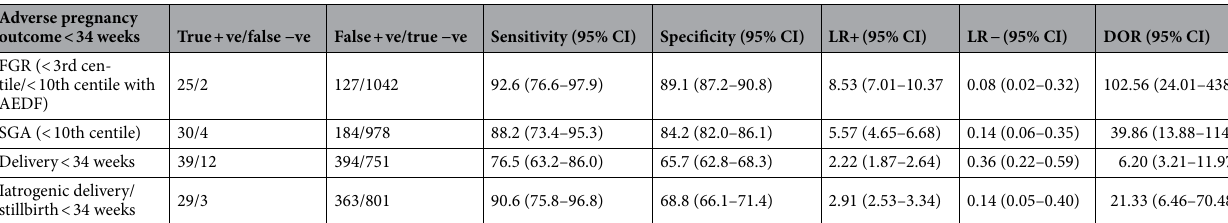
Table 2. 21–24 week placental screen test performance for adverse pregnancy outcomes before 34 weeks gestation. + ve positive, − ve negative, CI confidence interval, LR + positive likelihood ratio, LR− negative